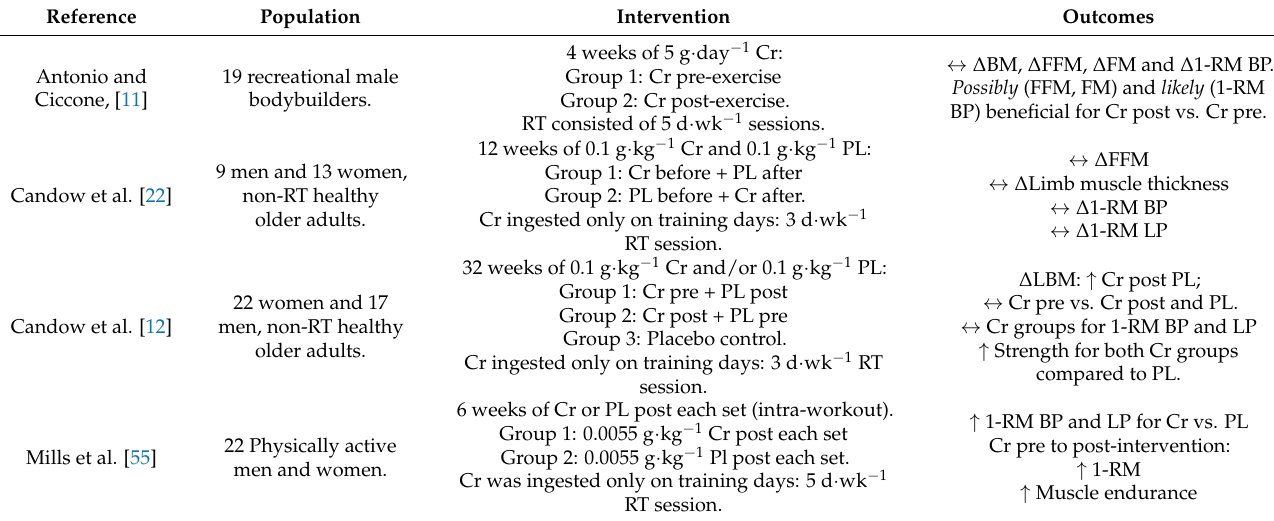
Table 1. Study protocols that investigated the timing effects of creatine supplementation before, during, and after exercise. Reference